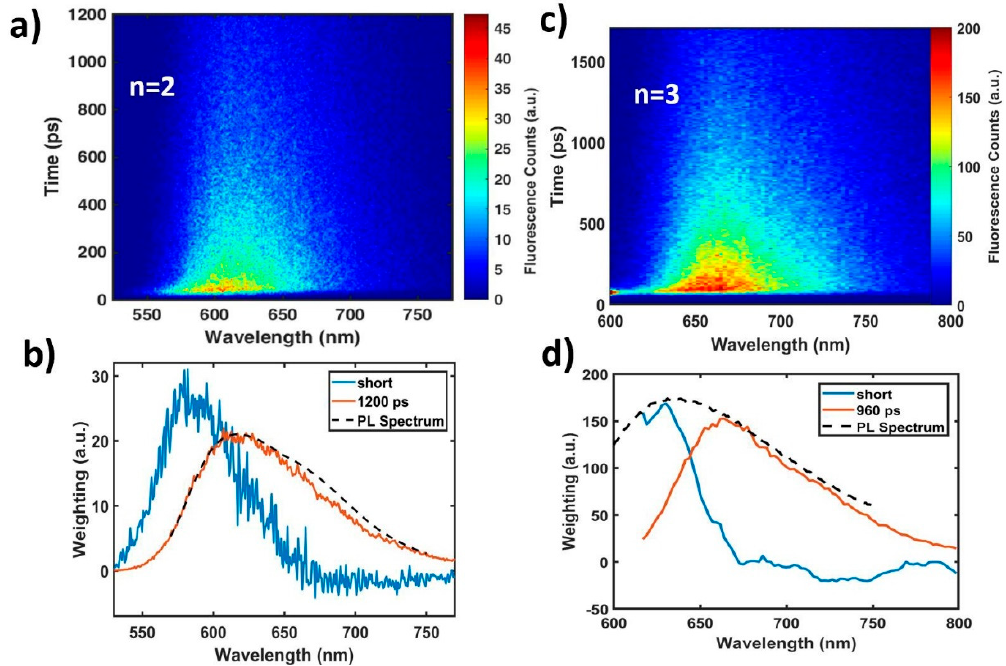
Figure 2. ( a ) Streak camera time-resolved fluorescence measurements of the n = 2 oligomer at 500 nm excitation. The time constant for the short-lived (blue line), blue-shifted fluorescent species is limited by the time resolution of the apparatus (Instrument response function FWHM ~20 ps). ( b ) Decay-associated spectra of streak camera data in ( a ). The blue-shifted component’s lifetime was too short to resolve. The steady state photoluminescence spectrum (dashed line) is scaled for comparison. ( c ) Same measurements as ( a ) for the n = 3 oligomer at 550 nm excitation, which show similar emission characteristics as n = 2 but considerably red-shifted in both short and longer-lived fluorescence peaks. ( d ) Decay-associated spectra of streak camera data for n = 3. The steady state photoluminescence spectrum is scaled arbitrarily for clarity.